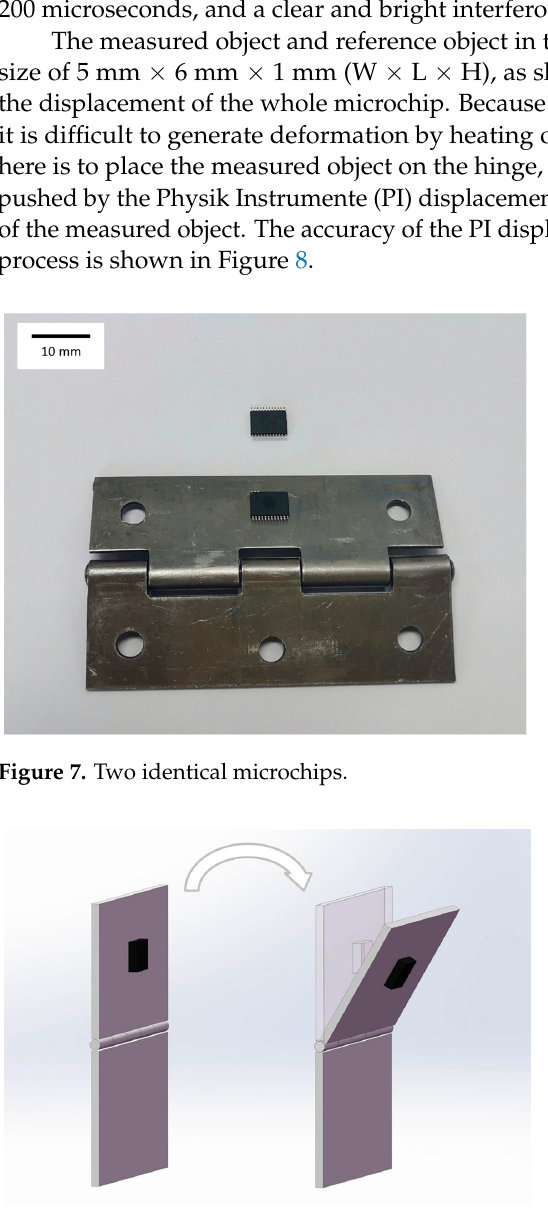
Figure 6. The measurement system diagram with the introduction of doublet lens group.